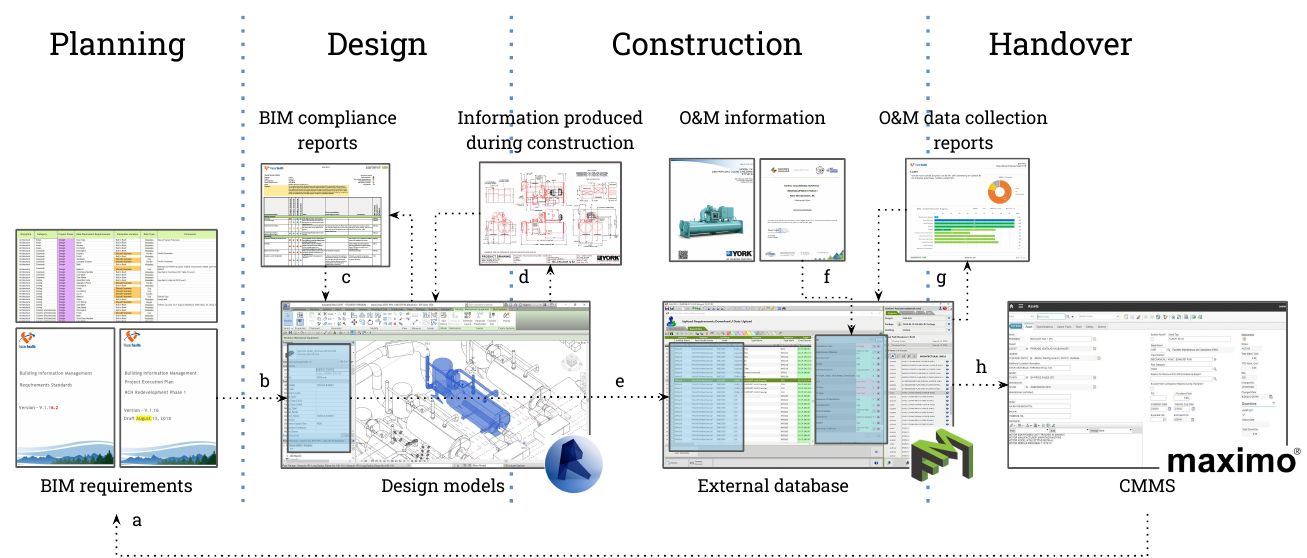
Figure 6. Schematic representation of the asset information delivery process in BIM. Legend: ( a ) Defi- nition of the information requirements (BIM requirements). ( b ) Model development observing BIM requirements (creation of digital assets in BIM). ( c ) Validation of the asset information in BIM (com- pliance with BIM requirements). ( d ) Model updates based on design changes during construction. ( e ) Data extraction from design models into an external database (creation of an asset registry). ( f ) As- sociation of asset information from construction phase with respective digital assets in the external database. ( g ) Validation of the asset information in the external database. ( h ) Asset information upload into FM